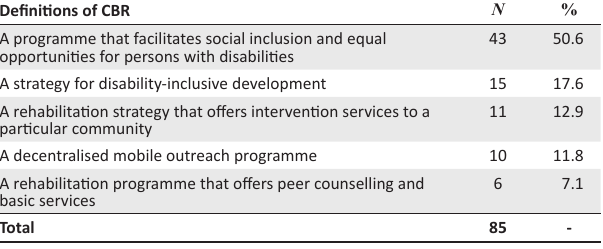
FIG URE 3: Cross-tabulation of respondents’ exposure to community-based rehabilitation (CBR) and familiarity with the CBR guidelines (multiple responses allowed). TABLE 2: Definitions of community-based rehabilitation selected by respondents ( N = 85) Definitions of CBR